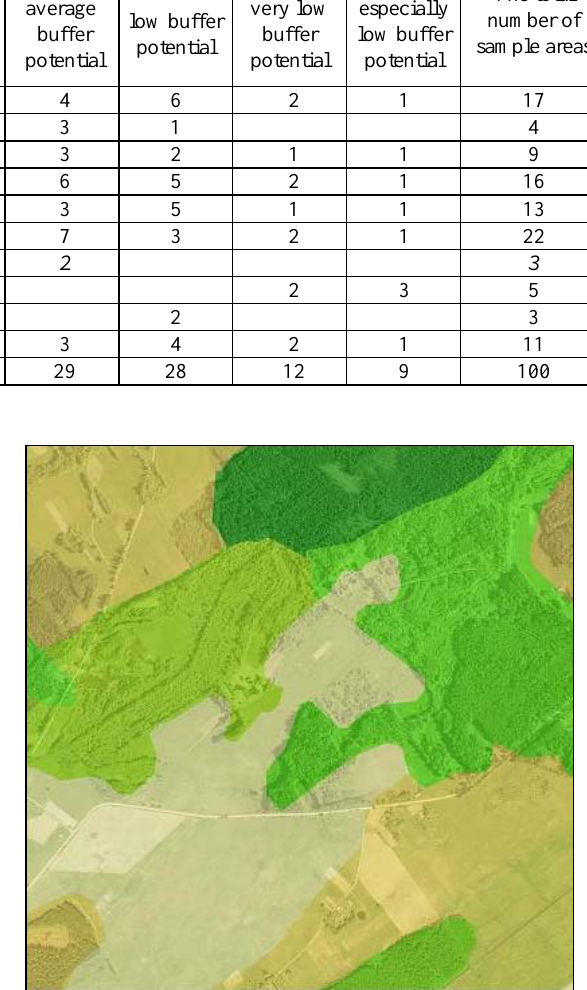
Table 3. Proposed distribution of sample number in landscape types taking into account the percentage of geochemical toposystems according to buffer potential Buffer potential of geochemical toposystems Main landscape types